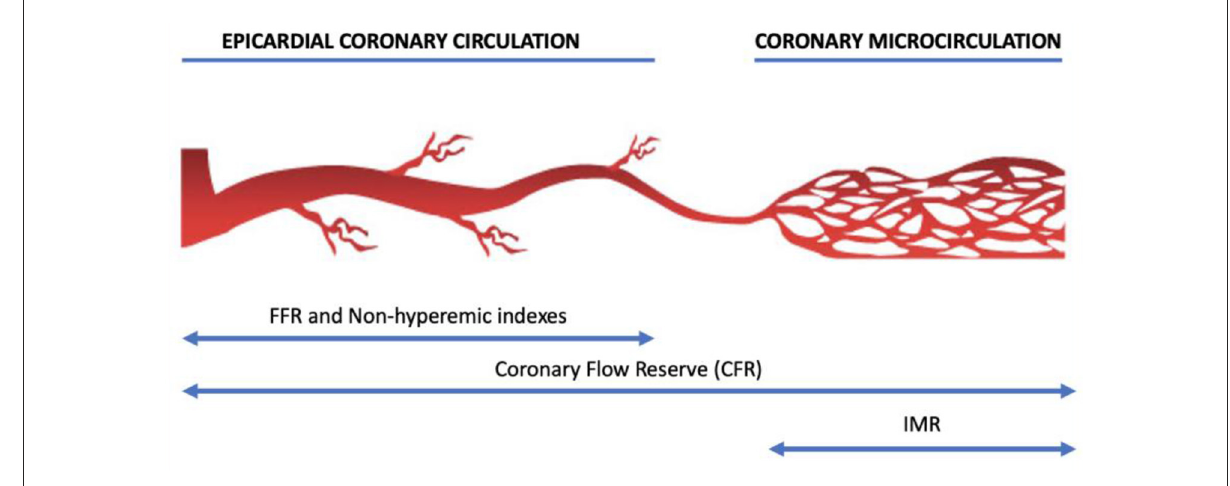
FIGURE1 The structure of coronary macrocirculation and microcirculation and the corresponding action fields of physiological techniques.